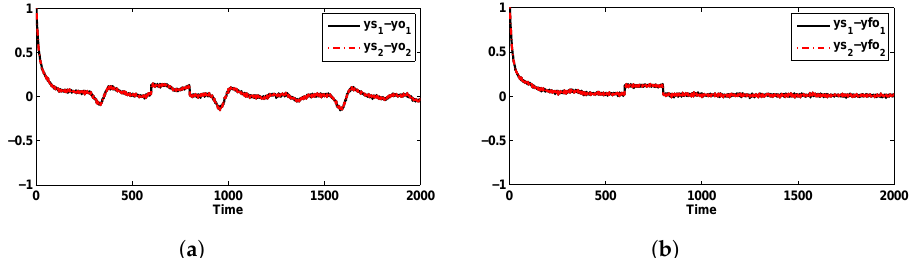
Figure 6. Output for error estimation faulty case. ( a ) Outputs for error estimation between the FOTS system and FUIO in a faulty case. ( b ) Outputs error estimation between the FOTS system and FOUIO in a faulty case.